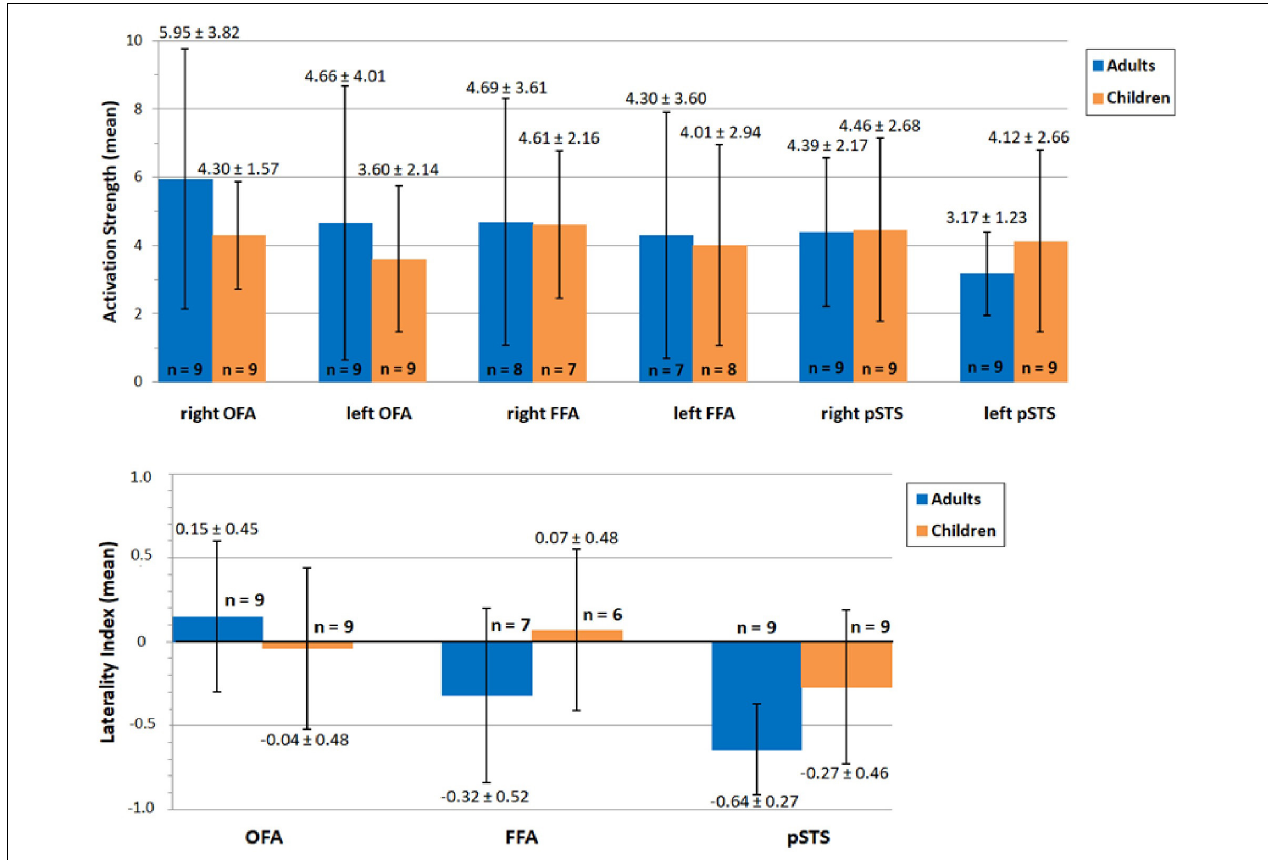
FIGURE 6 | Mean activation (top) and lateralization (bottom) of OFA, FFA and pSTS during face processing in adults (blue) and children (orange). Values of mean activation/lateralization ± SD are specified above/below error bars. The number of included subjects is depicted at the bottom of/above each bar. None of the differences reached statistical significance ( p > 0.05). OFA, occipital face area; FFA, fusiform face area; pSTS, posterior superior temporal